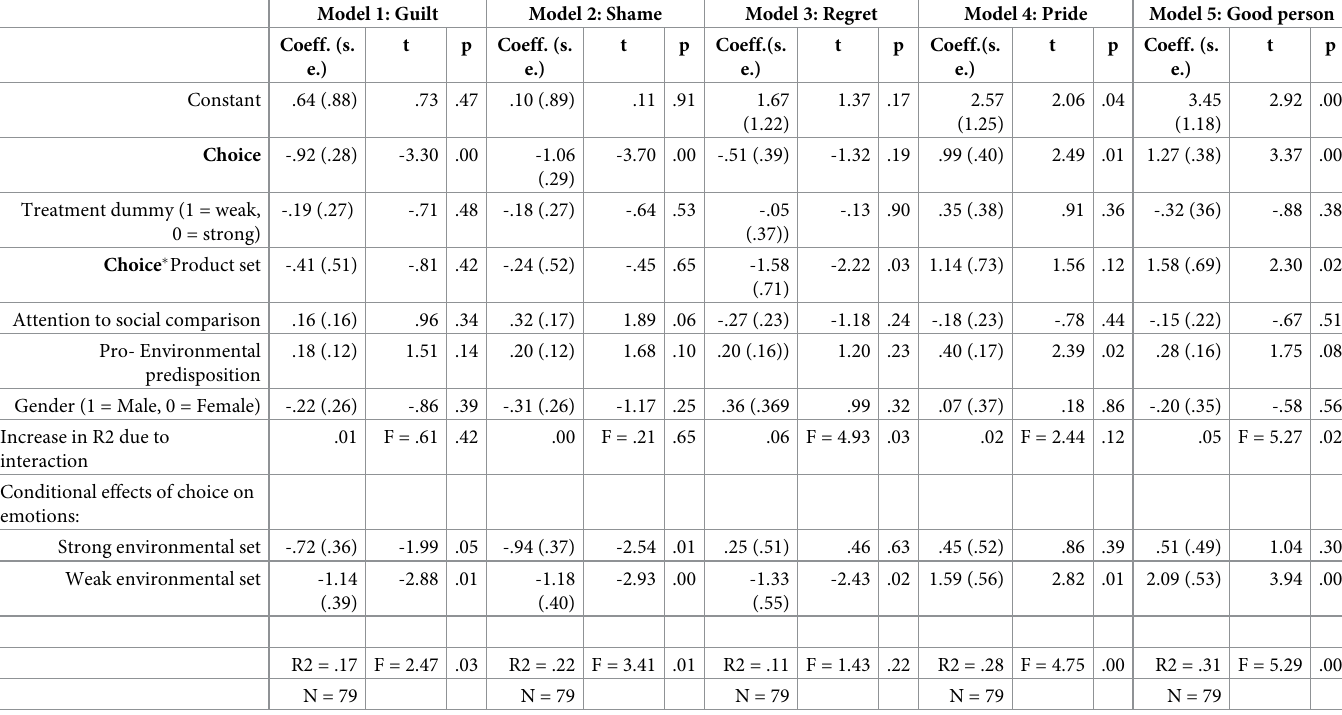
Table 5. Conditional linear regressions of choice on emotions, moderated by product set